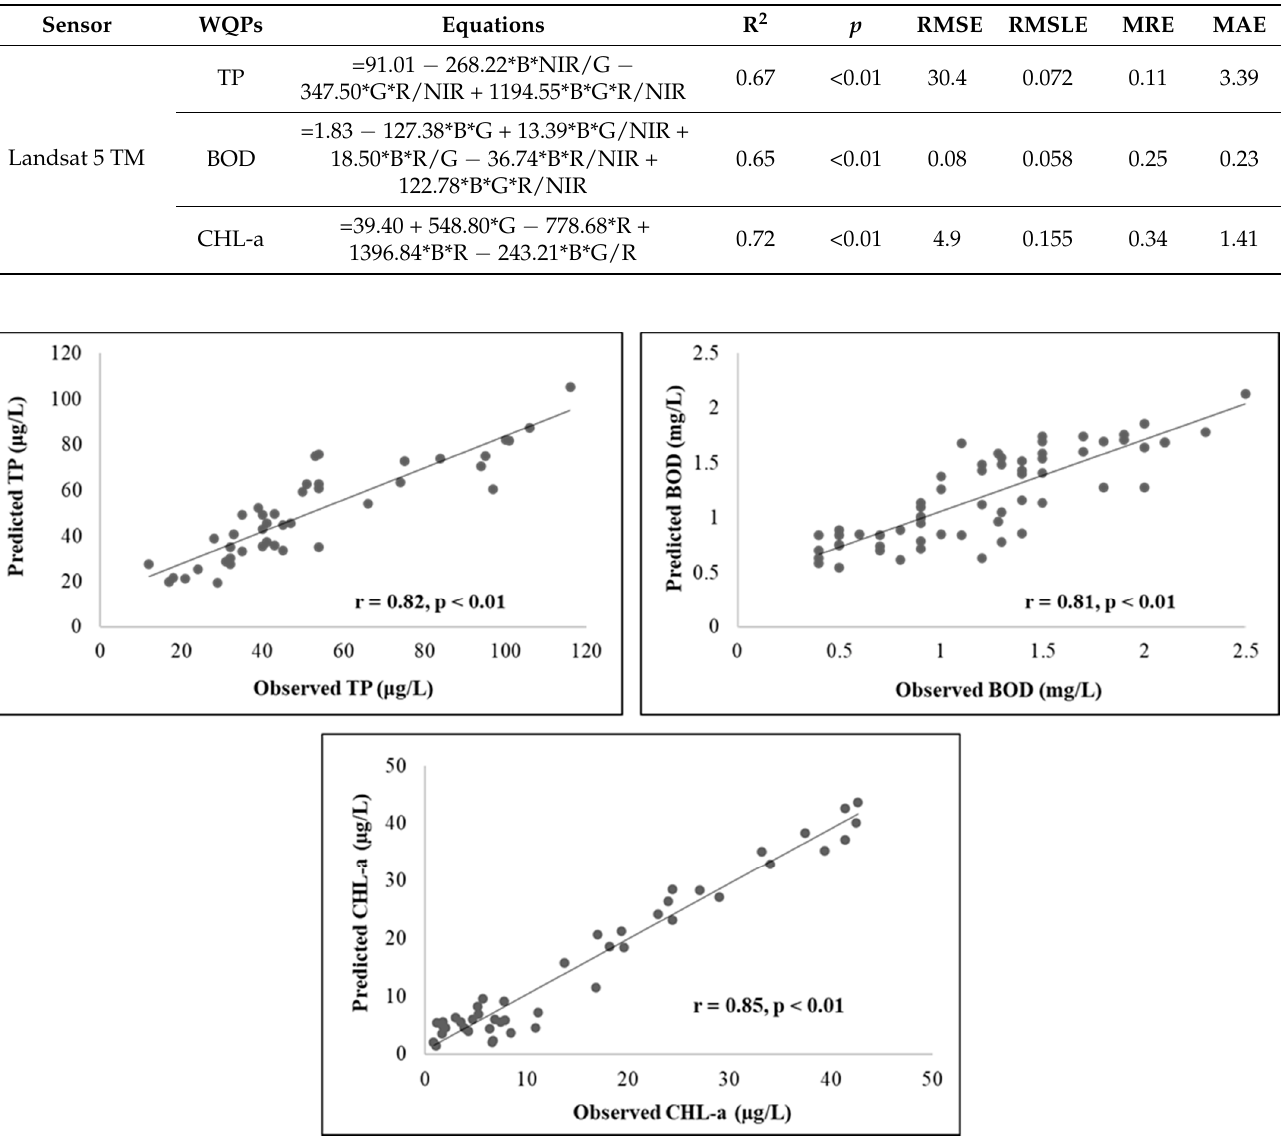
Figure 3. The relationship among observed and predicted TP, BOD and CHL-a for Landsat 5 TM (TP: Total Phosphorus, BOD: Biological Oxygen Demand, and CHL-a: Chlorophyll-a).